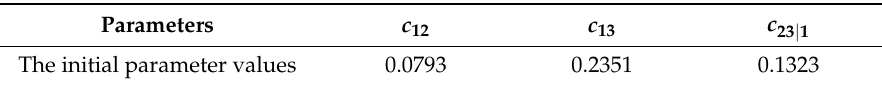
Table 3. The initial values of estimation.